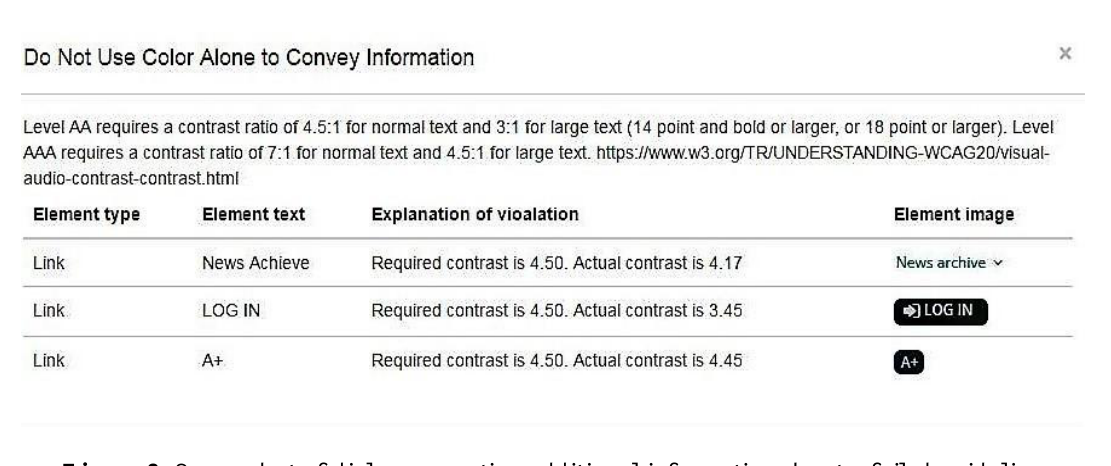
Figure 8. Screenshot of dialog presenting additional information about a failed